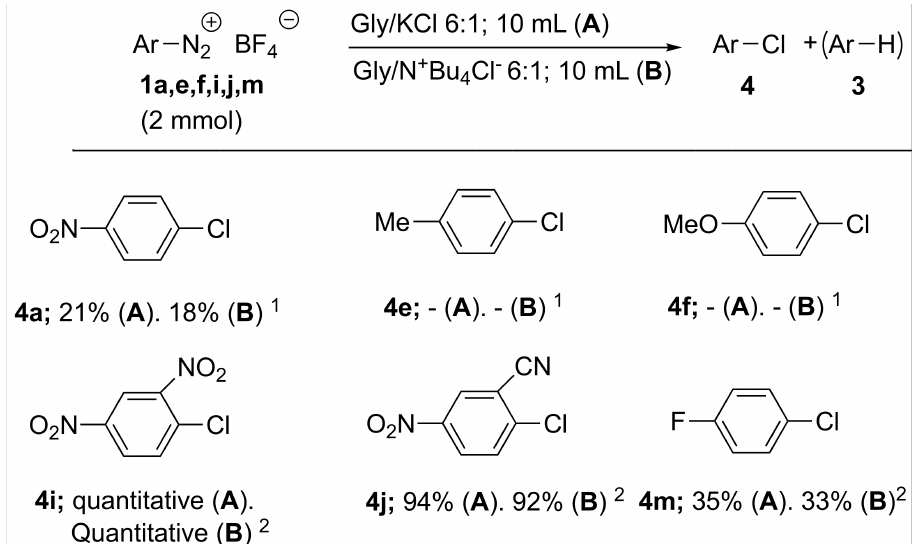
Figure 2. Chlorodediazotation scope. 1 Reaction was carried out at 35 ◦ C for 4 h with 20 mL of solvent. Longer reaction times or higher amounts of solvent systems did not lead to increased yields. Yields refer to pure and isolated 4. GC and GC-MS analyses showed the presence of 3a as main product or 3e and 3f as only products. 2 Reactions were carried out at room temperature for 4 h: 2 mmol of salts 1 and 10 mL of Gly/KCl (method A) or 10 mL of Gly/TBAC (method B). Yields refer to pure and isolated 4 .